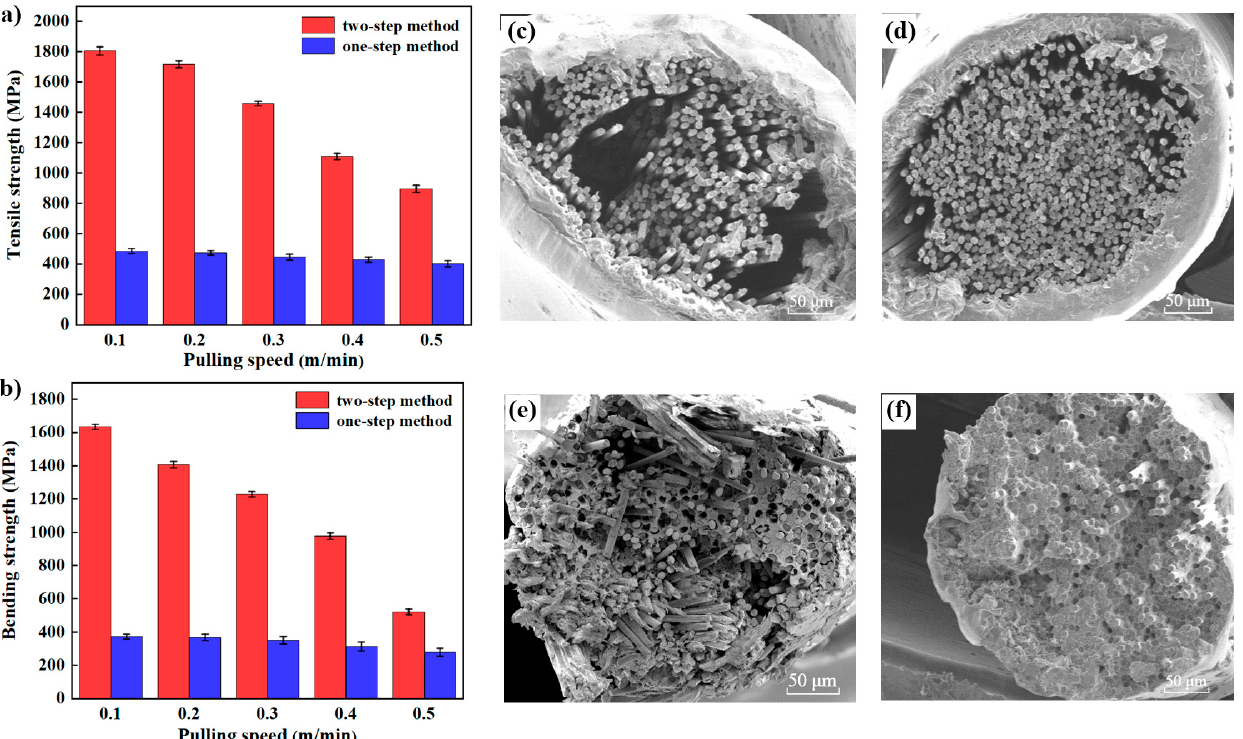
Figure 6. ( a ) Tensile strength and ( b ) bending strength of composite wires from different methods at different pulling speeds. ( c – d ) Cross-sectional SEM images of composite wire via one-step method at a pulling speed of ( c ) 0.5 m/min and ( d ) 0.1 m/min. ( e – f ) Cross-sectional SEM images of composite wire via two-step method at a pulling speed of ( e ) 0.5 m/min and ( f ) 0.1